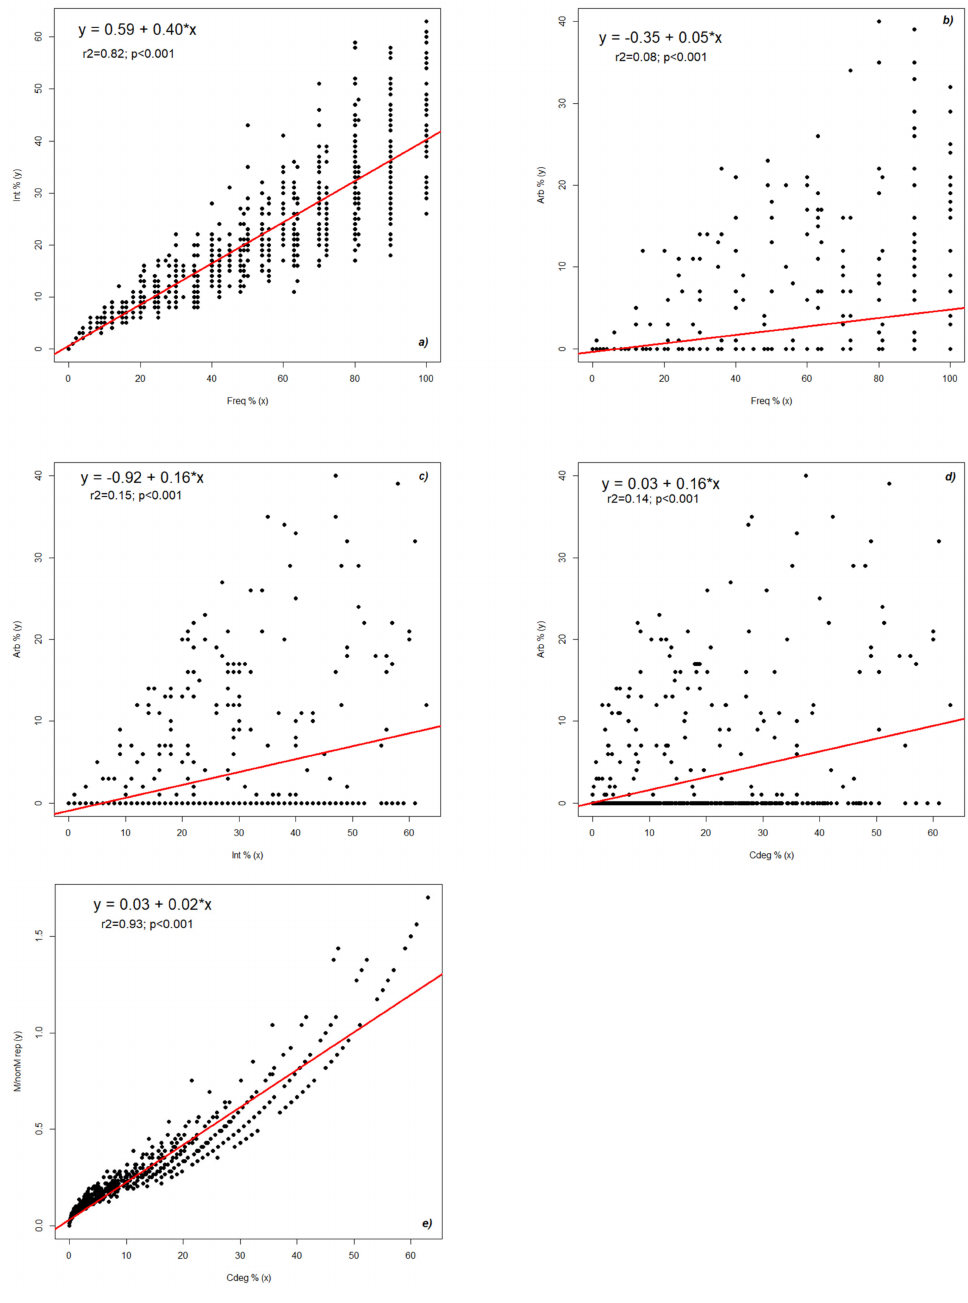
Figure 3. The interdependence of mycorrhizal parameters in the roots of Festuca rubra : ( a ) frequency vs. intensity, ( b ) frequency vs. arbuscules, ( c ) intensity vs. arbuscules, ( d ) degree of colonization vs. arbuscules, and ( e ) degree of colonization vs. mycorrhizal/non-mycorrhizal area ratio. Legend: Freq—frequency of colonization; Int—intensity of colonization; Arb—arbuscules abundance; Cdeg— colonization degree; M/nonM rep—mycorrhizal/non-mycorrhizal area